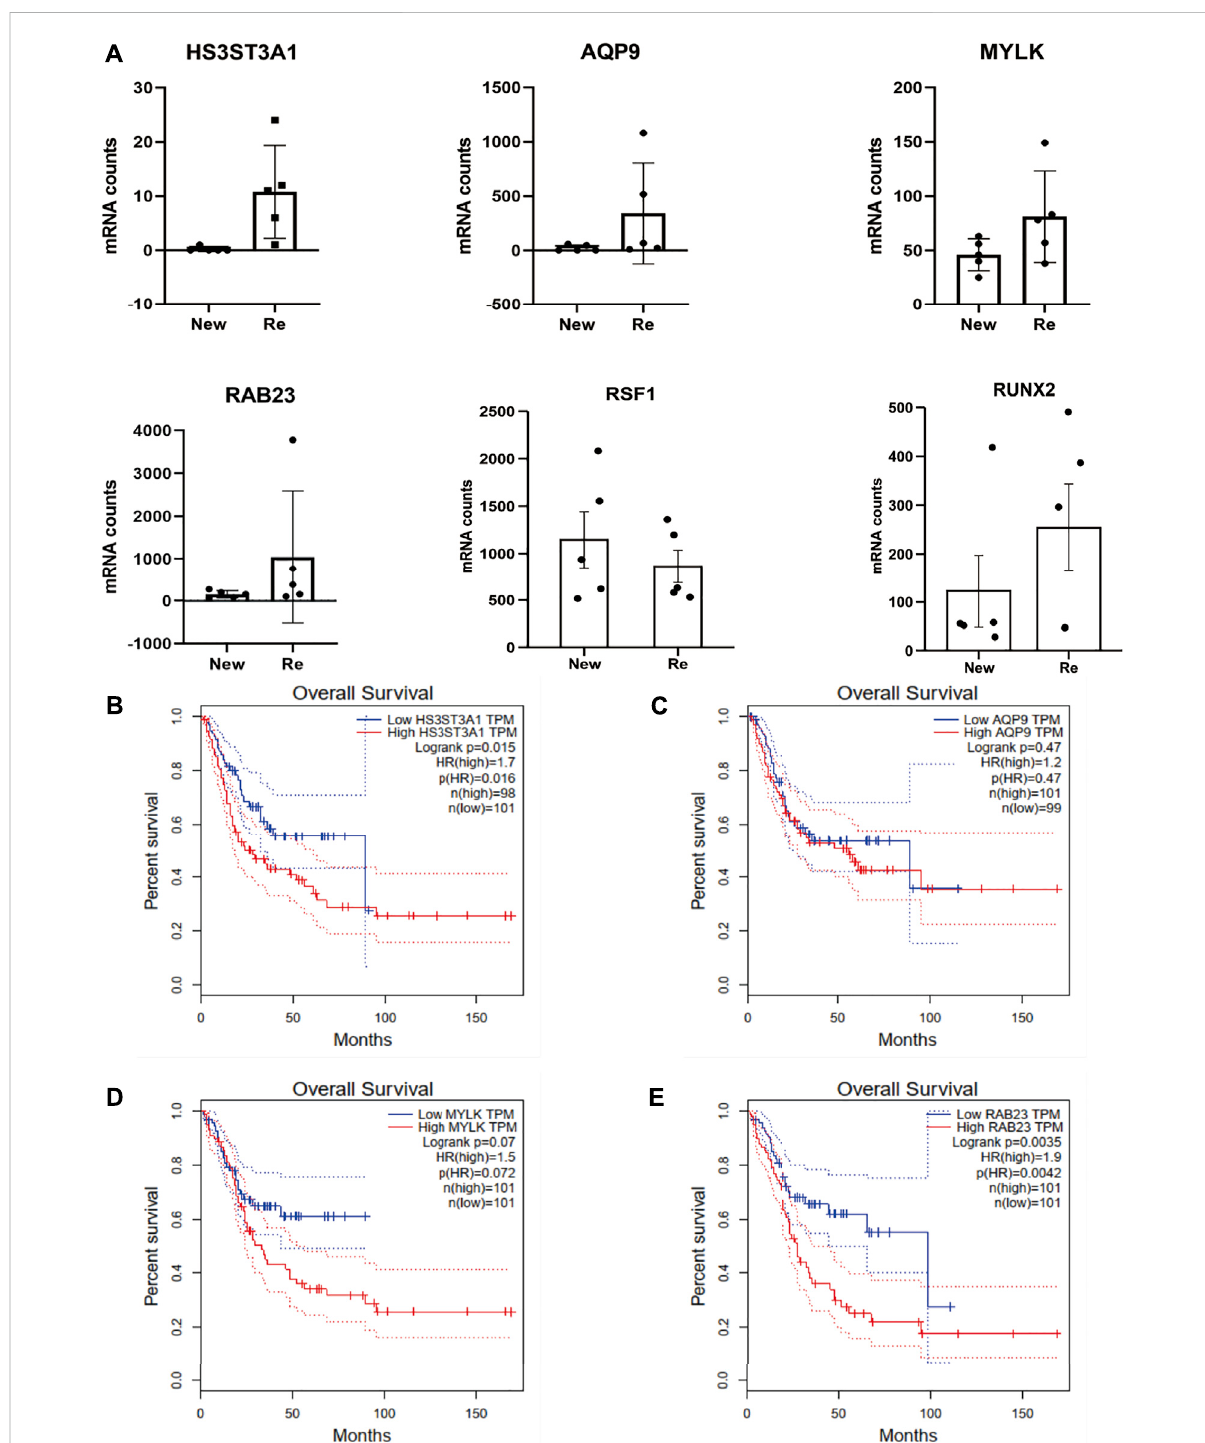
FIGURE 5 Expression levelsofmir-154-5ptargets arepotentiallyregulatedbytheeditingofmir-154-5p otherthantheexpression levelofmir-154-5p. (A) A Bar plot showing the mRNA expression level of mir-154 targets. HS3ST3A1, AQP9, MYLK, and RAB23 are signi fi cantly differentially expressed in recurrent vs. primary tumors, with a p -value after FDR correction < 0.001. (B – E) Survival plots of the four top targets (high expression; > 50% vs. low expression < 50%). Survival data were extracted from TCGA bladder cancer